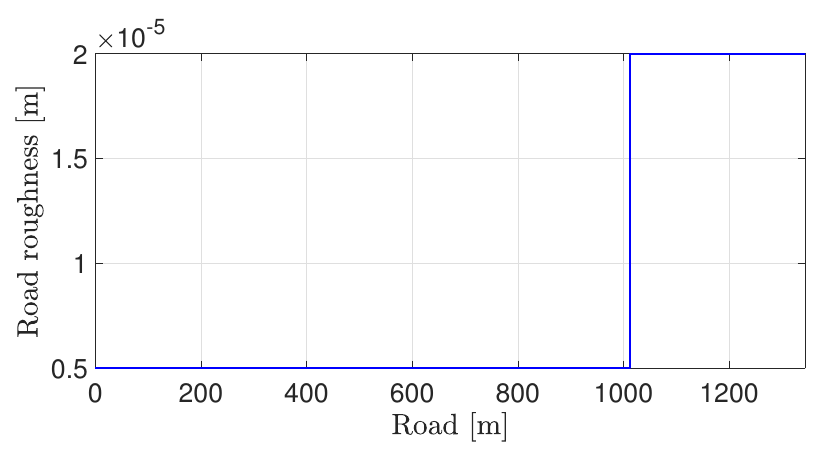
Figure 19. Road roughness.